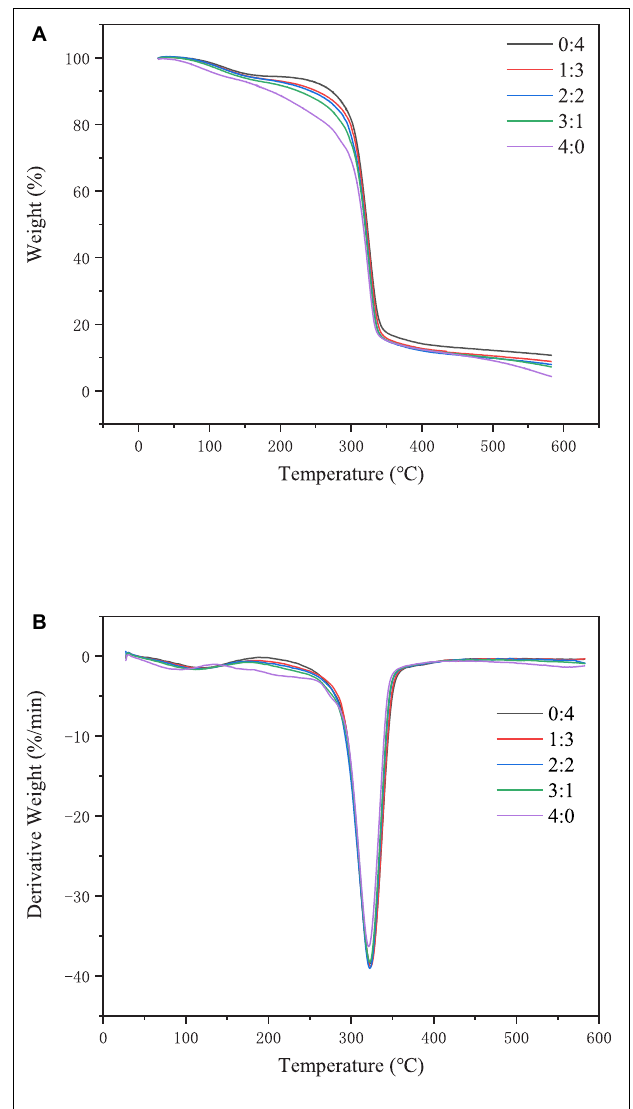
FIGURE 5 | TGA (A) and DTG (B) of corn starch-based films supplemented with GLY and ERY (4:0, 3:1, 2:2, 1:3, and 0:4).